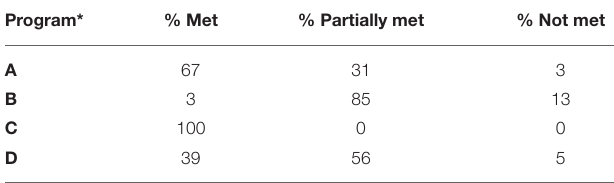
TABLE 4 | Percentage of total metrics met, partially met, or not met by all